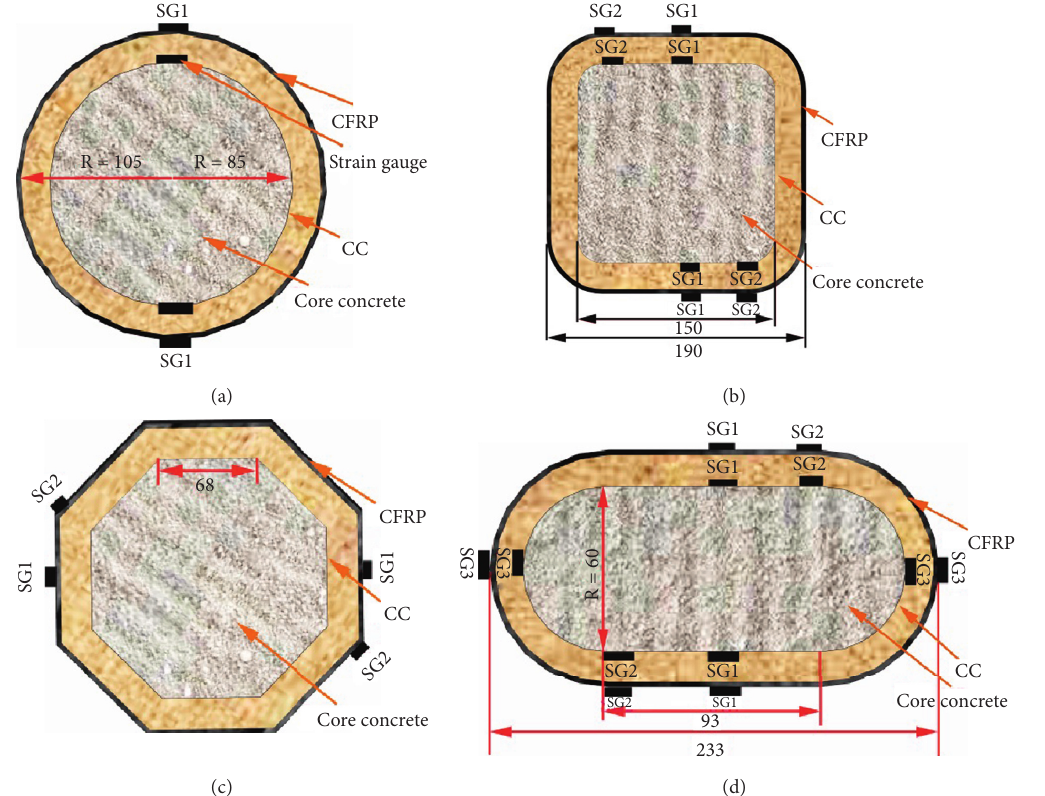
Figure 1: Schematic diagram of the reinforced column dimensions and strain gauge arrangement. (a) Circle. (b) Square. (c) Octagon. (d) Ellipse.